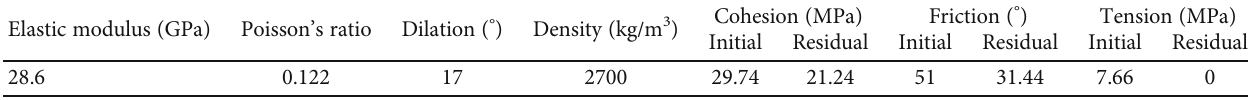
Table 4: Mechanical parameters of Beishan granite.